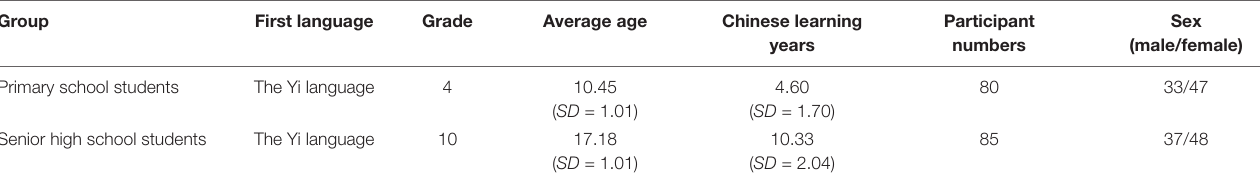
TABLE 1 | Demographic information of the participants.